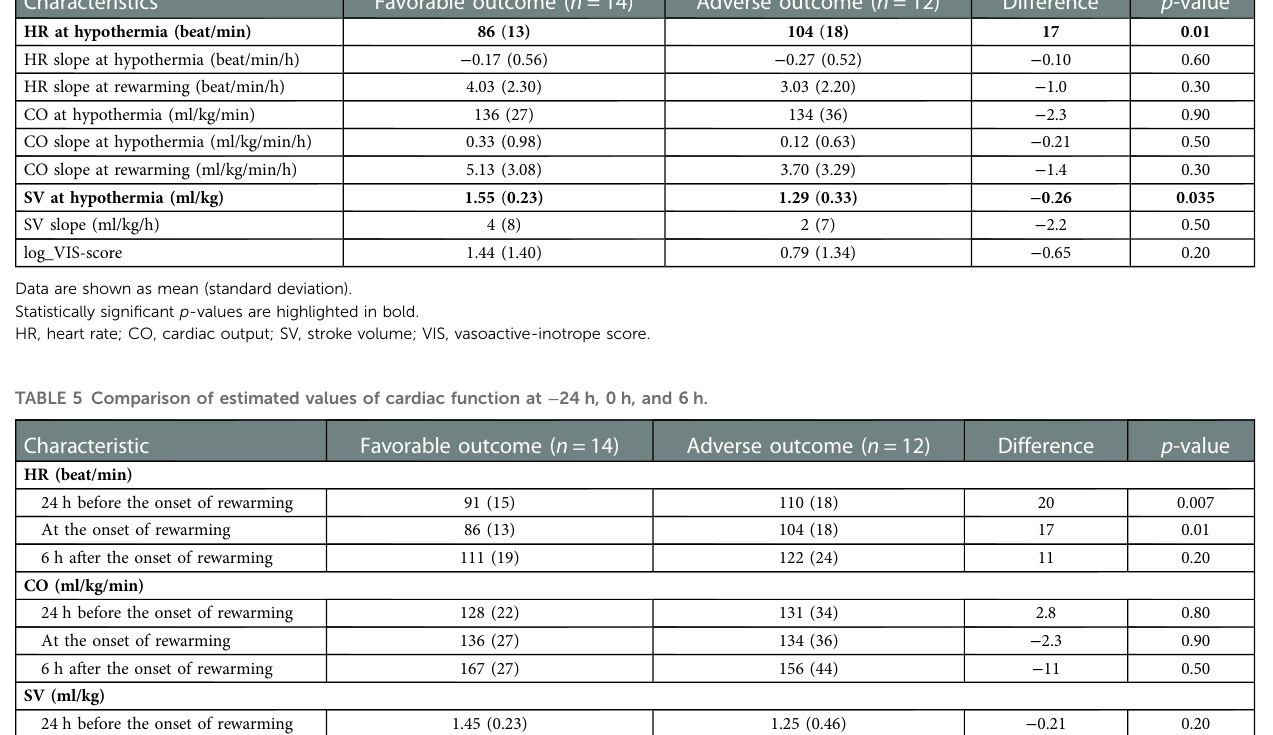
TABLE 4 Estimated individual time-series features. Characteristics